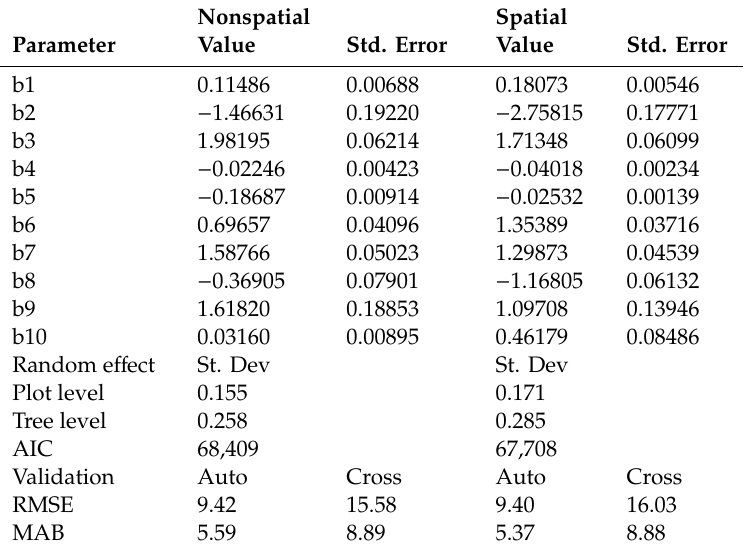
Table 3. Summary of the selected nonspatial and spatial models. All parameters were significant with p values < 0.001. AIC is Akaike Information Criteria, RMSE is root mean square error, MAB is mean absolute error. Validation results are provided for both auto-validation with all data and leave-one-out cross-validation at plot level. Nonspatial Spatial Parameter Value Std. Error Value Std.